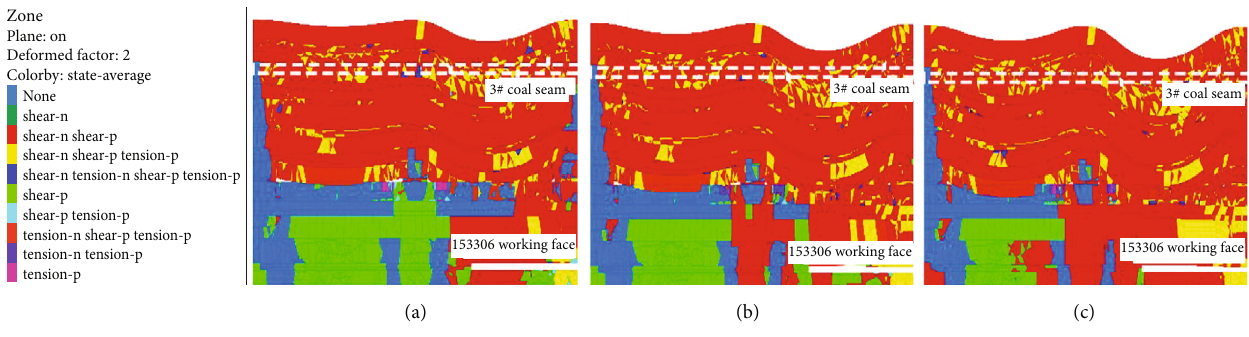
Figure 7: Cloud image of plastic zone in no. 3 coal seam during mining of 153306 working face. (a) Working face advancing 80m; (b) working face advancing 160m; (c) working face advancing 240m.